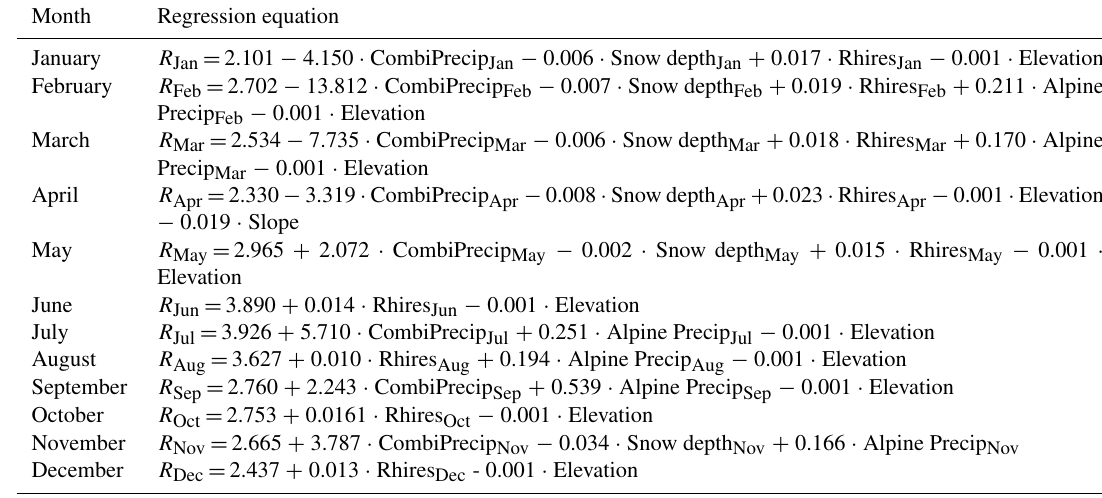
Table 2. Regression equations and selected covariates for estimating mean monthly rainfall erosivity in Switzerland. Month Regression equation